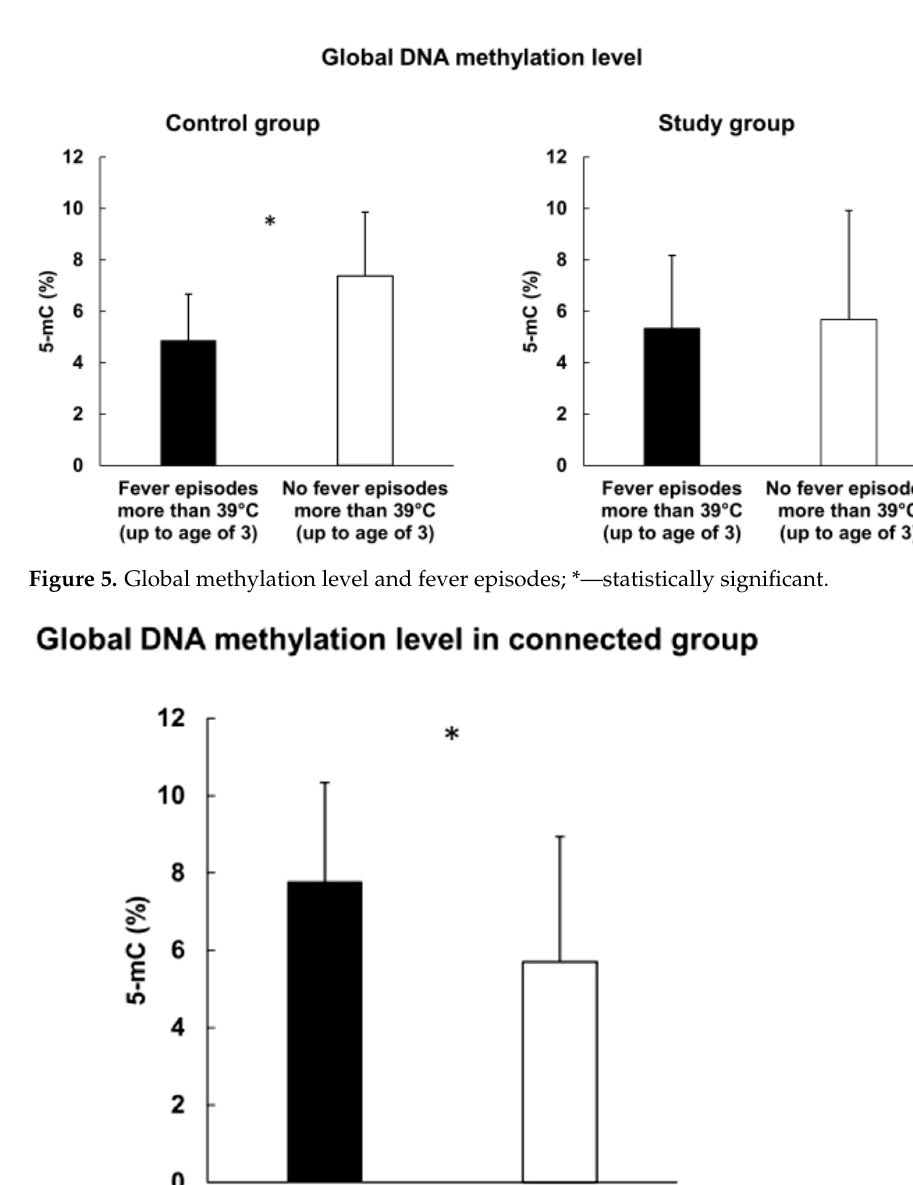
Figure 4. Global methylation level and type of delivery; *—statistically significant.